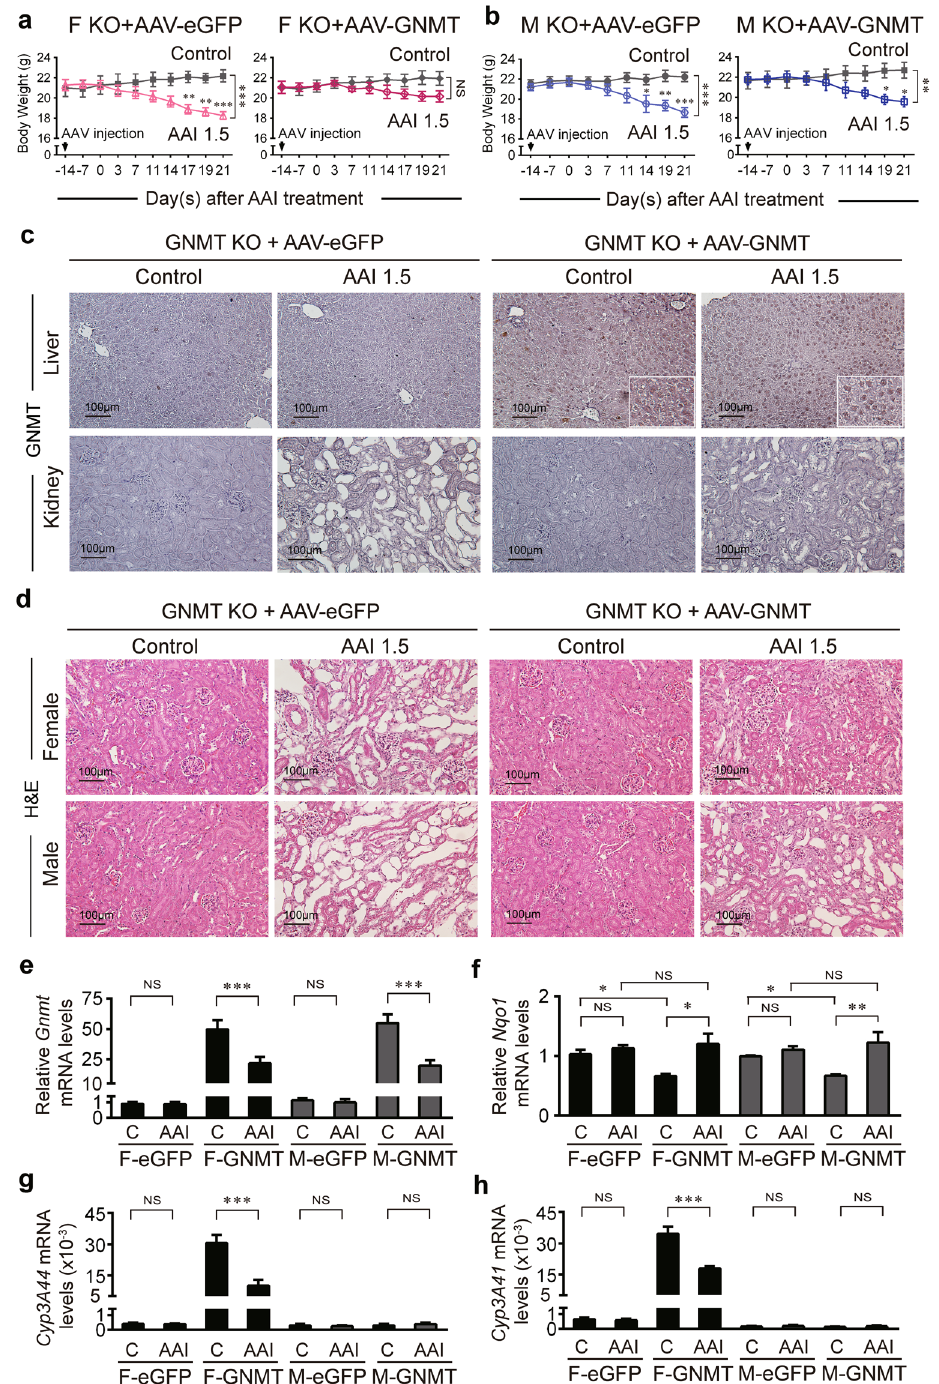
Figure 5. Re-expression hepatic GNMT reduces the AAI-induced nephropathy. GNMT knockout (KO) mice were intravenously injected with AAV-GNMT or AAV-eGFP. At 14 days after AAV injection, all mice were challenged with AAI at a dose of 1.5 mg/kg/day (AAI 1.5), 5 days/week for 3 weeks. ( a , b ) Body weight of AAV- GNMT or AAV-eGFP-treated KO mice intraperitoneally injected with AAI or corn oil (vehicle control). Values are presented as the mean ± SEM, n = 4. p -values were calculated by two-way ANOVA and Sidak’s multiple comparisons test. ( c ) Representative micrographs of GNMT expression in the liver and kidneys of the AAV-treated KO mice (original magnification × 200). ( d ) Hematoxylin and eosin staining of kidneys in AAV-treated KO mice after 3-week AAI exposure (original magnification × 200). ( e–h ) mRNA level of ( e ) Gnmt , ( f ) Nqo1 , ( g ) Cyp3A44, and ( h ) Cyp3A41 genes from the livers of AAV-treated KO mice after 3-week AAI exposure, as described in ( a , b ), were determined by qPCR. Data were normalized by β -actin. (F-eGFP: female KO mice treated with AAV-eGFP, F-GNMT: female GNMT KO mice treated with AAV-GNMT, M: Male) Values are presented as the mean ± SEM, n = 5. p -values were calculated using Student’s t -test. * p < 0.05, ** p < 0.001, *** p ≤